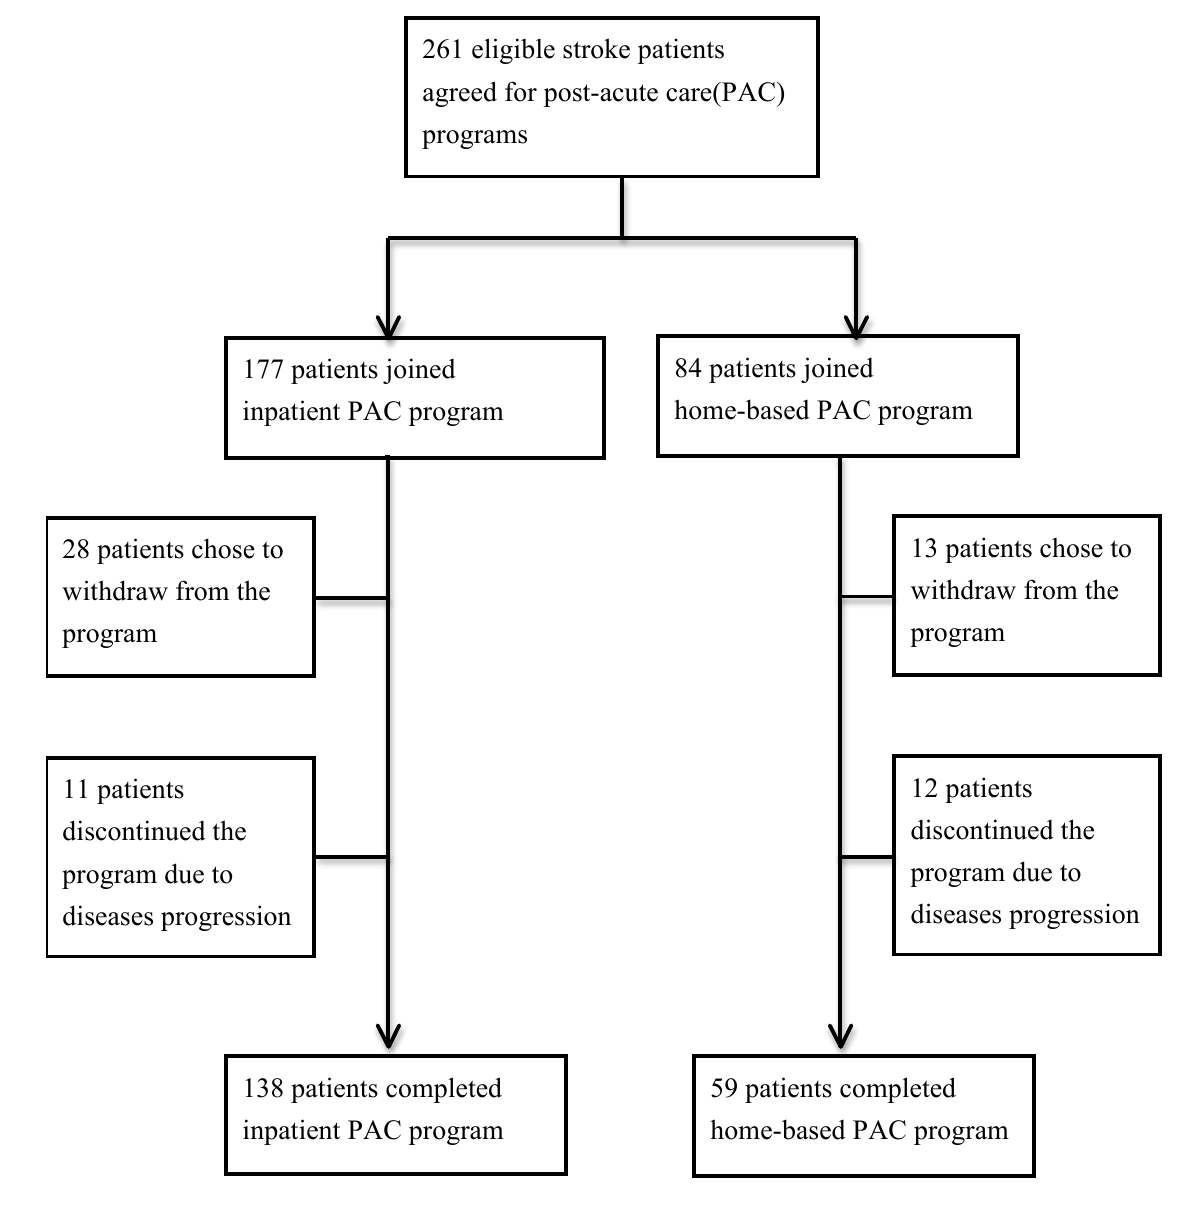
Figure 1. Enrollment in the